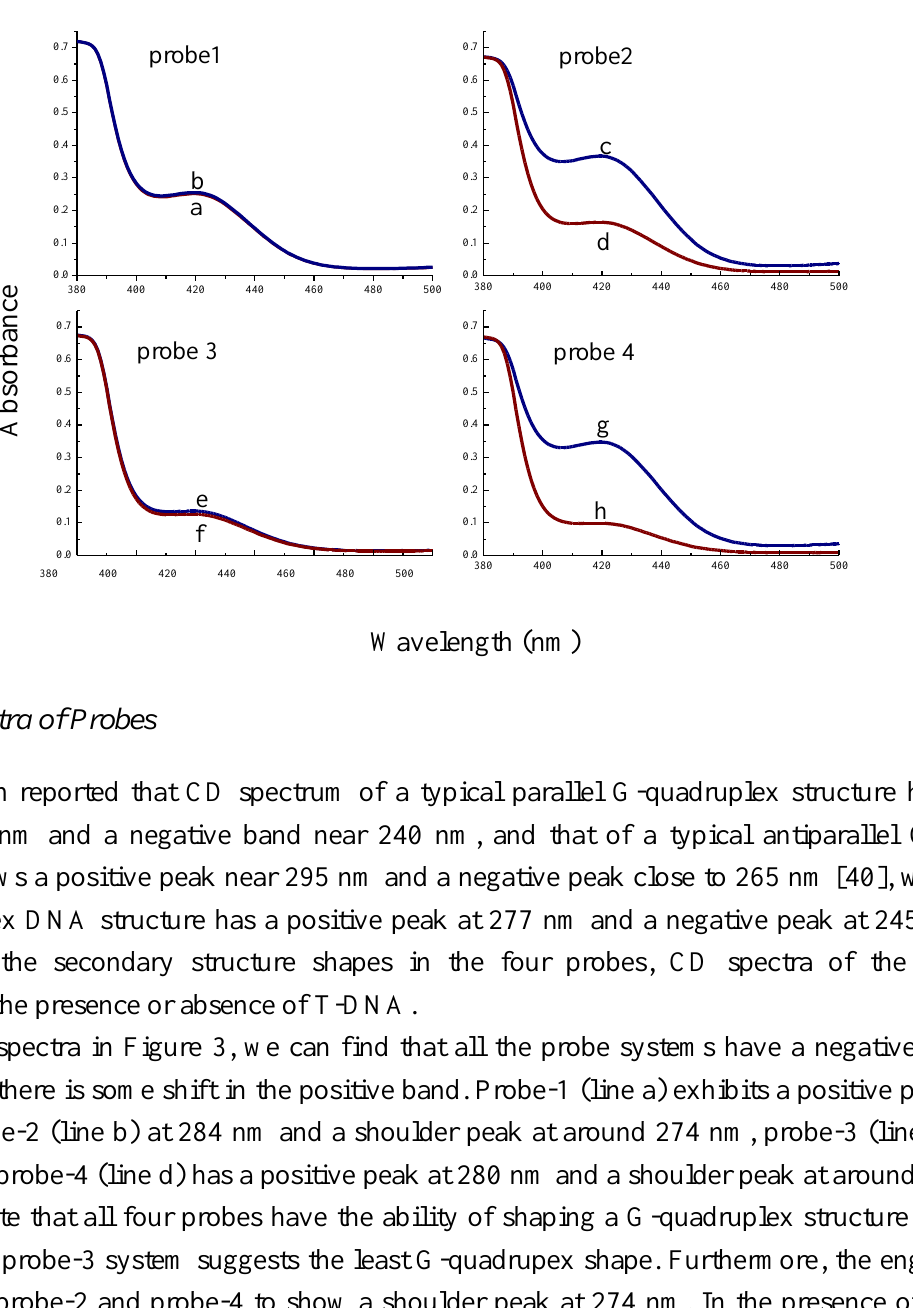
O mediated ABTS 2− colorimetric system. 2 2